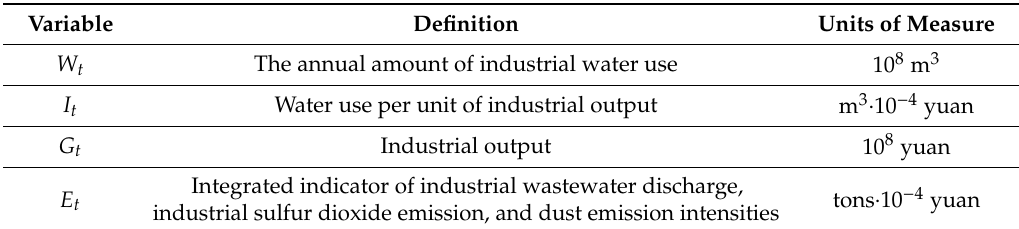
Table 2. Definition of all variables in this